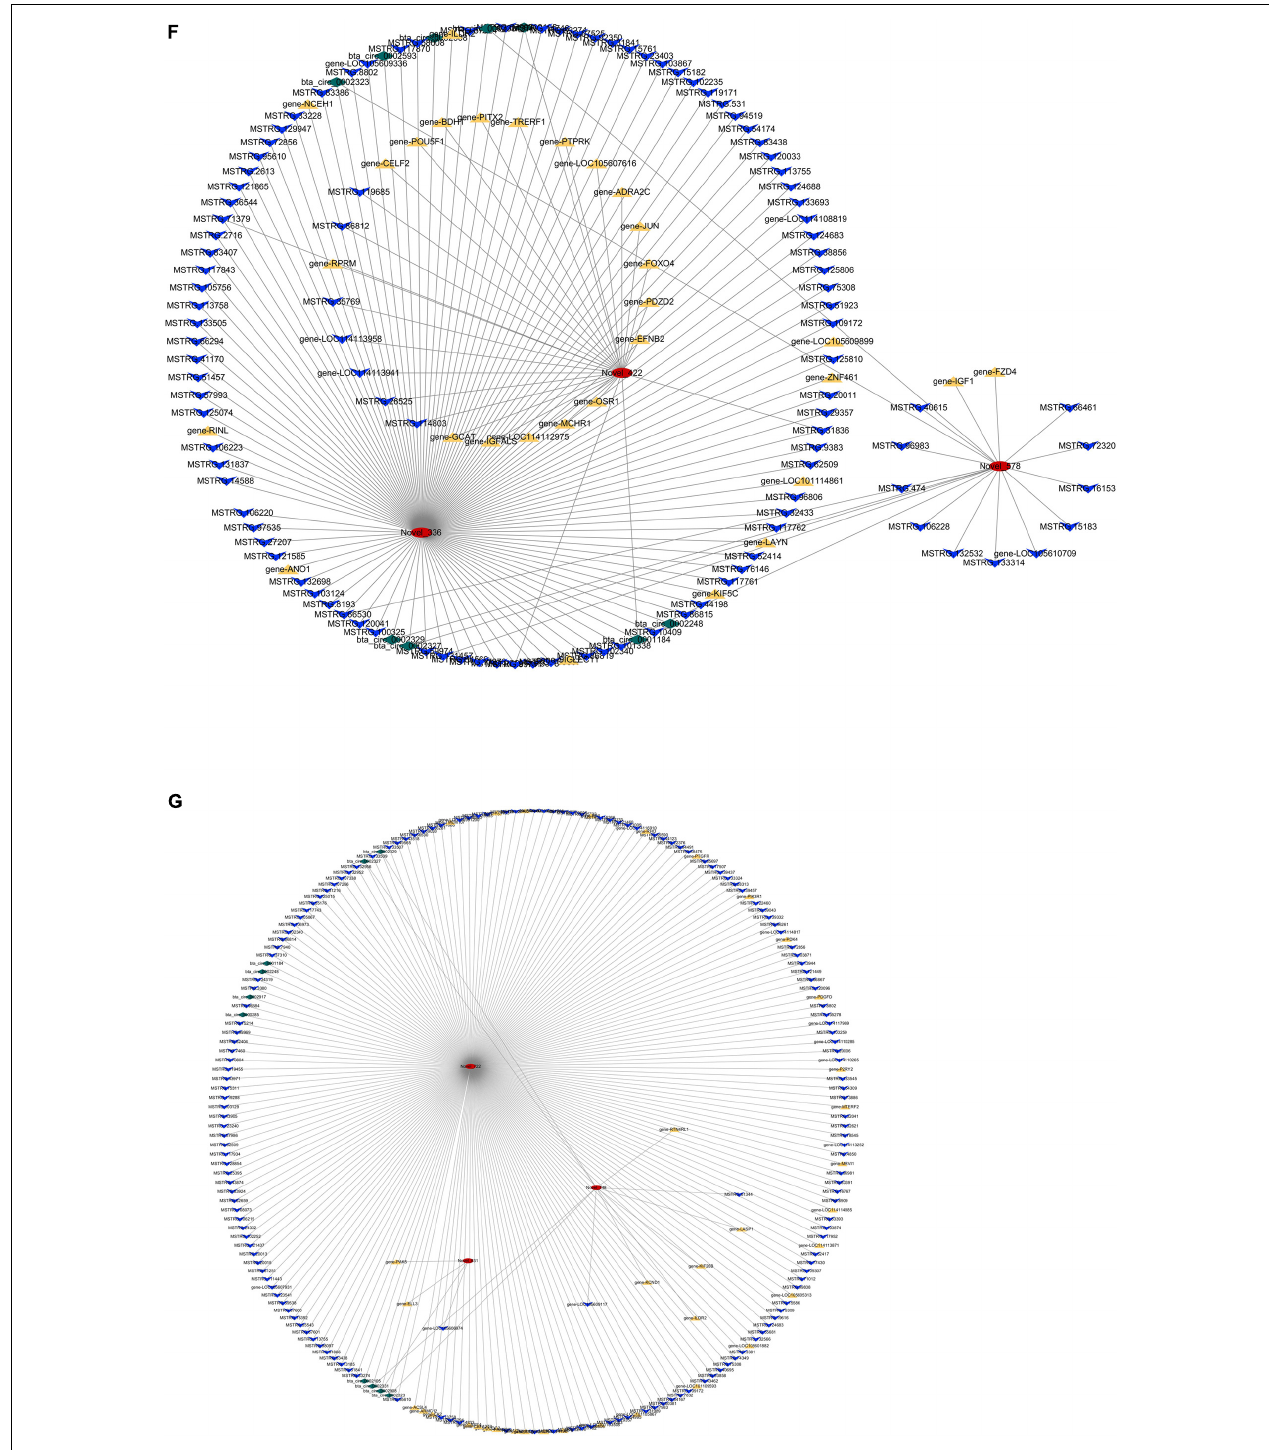
FIGURE 3 | Regulatory networks from preadipocytes to mature adipocytes. (A) Circular RNA (circRNA)–microRNA (miRNA) network regulation diagram; the red graphic is miRNA, and the green graphic is circRNA. (B) miRNA–messenger RNA (mRNA) network regulation diagram; the yellow graphic is mRNA. (C) Long non-coding RNA (lncRNA)–miRNA–mRNA network regulation diagram; the blue graphic is mRNA. (D) circRNA–miRNA–mRNA network regulation diagram between M1 vs. P1 and M2 vs. P2 groups. (E) circRNA–miRNA–mRNA network regulation diagram between M2 vs. P2 and M3 vs. P3 groups. (F) LncRNA–circRNA–miRNA–mRNA network regulation diagram between M1 vs. P1 and M2 vs. P2 groups. (G) LncRNA–circRNA–miRNA–mRNA network regulation diagram between M2 vs. P2 and M3 vs. P3